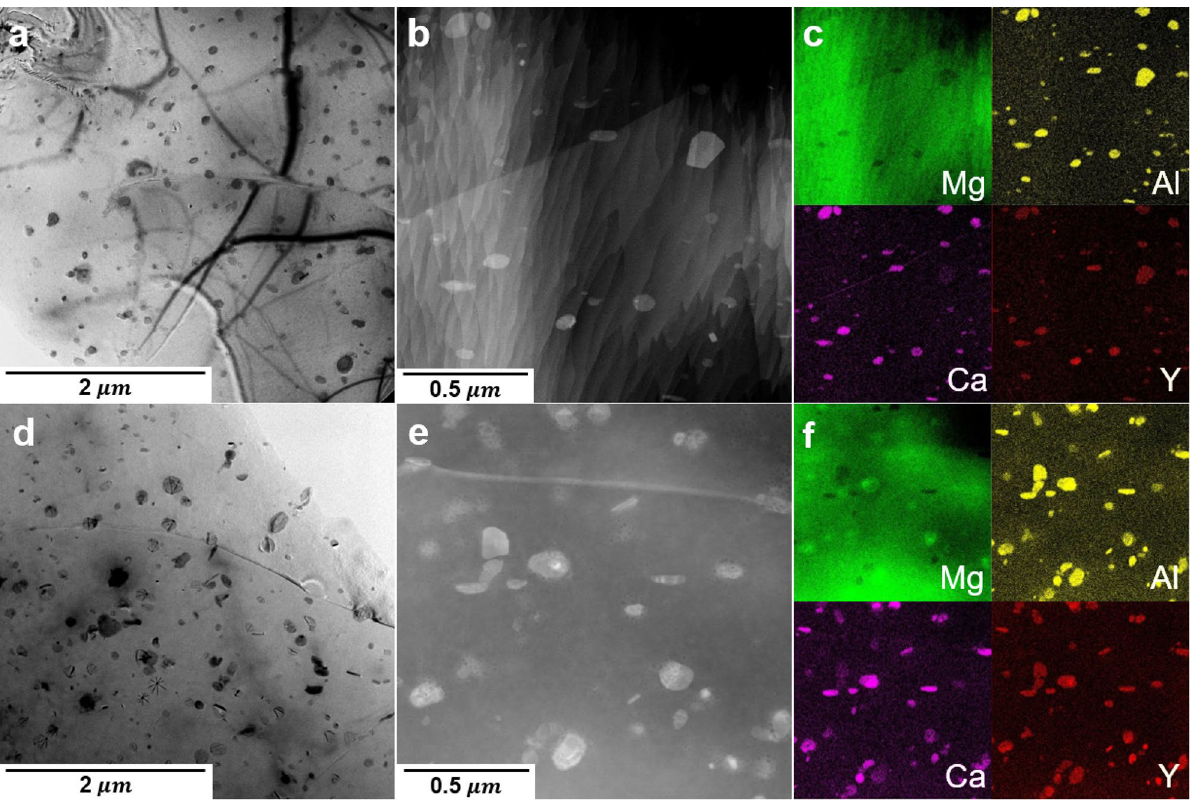
Figure 6. TEM images of ( a ) the homogenized and ( d ) peak-aged AXW100 alloy. High-magnified STEM images and corresponding EDS maps of ( b , c ) the homogenized and ( e , f ) peak-aged AXW100 alloy for Mg, Al, Ca and Y. Elements Stoichiometry Points Al Ca Y Mg